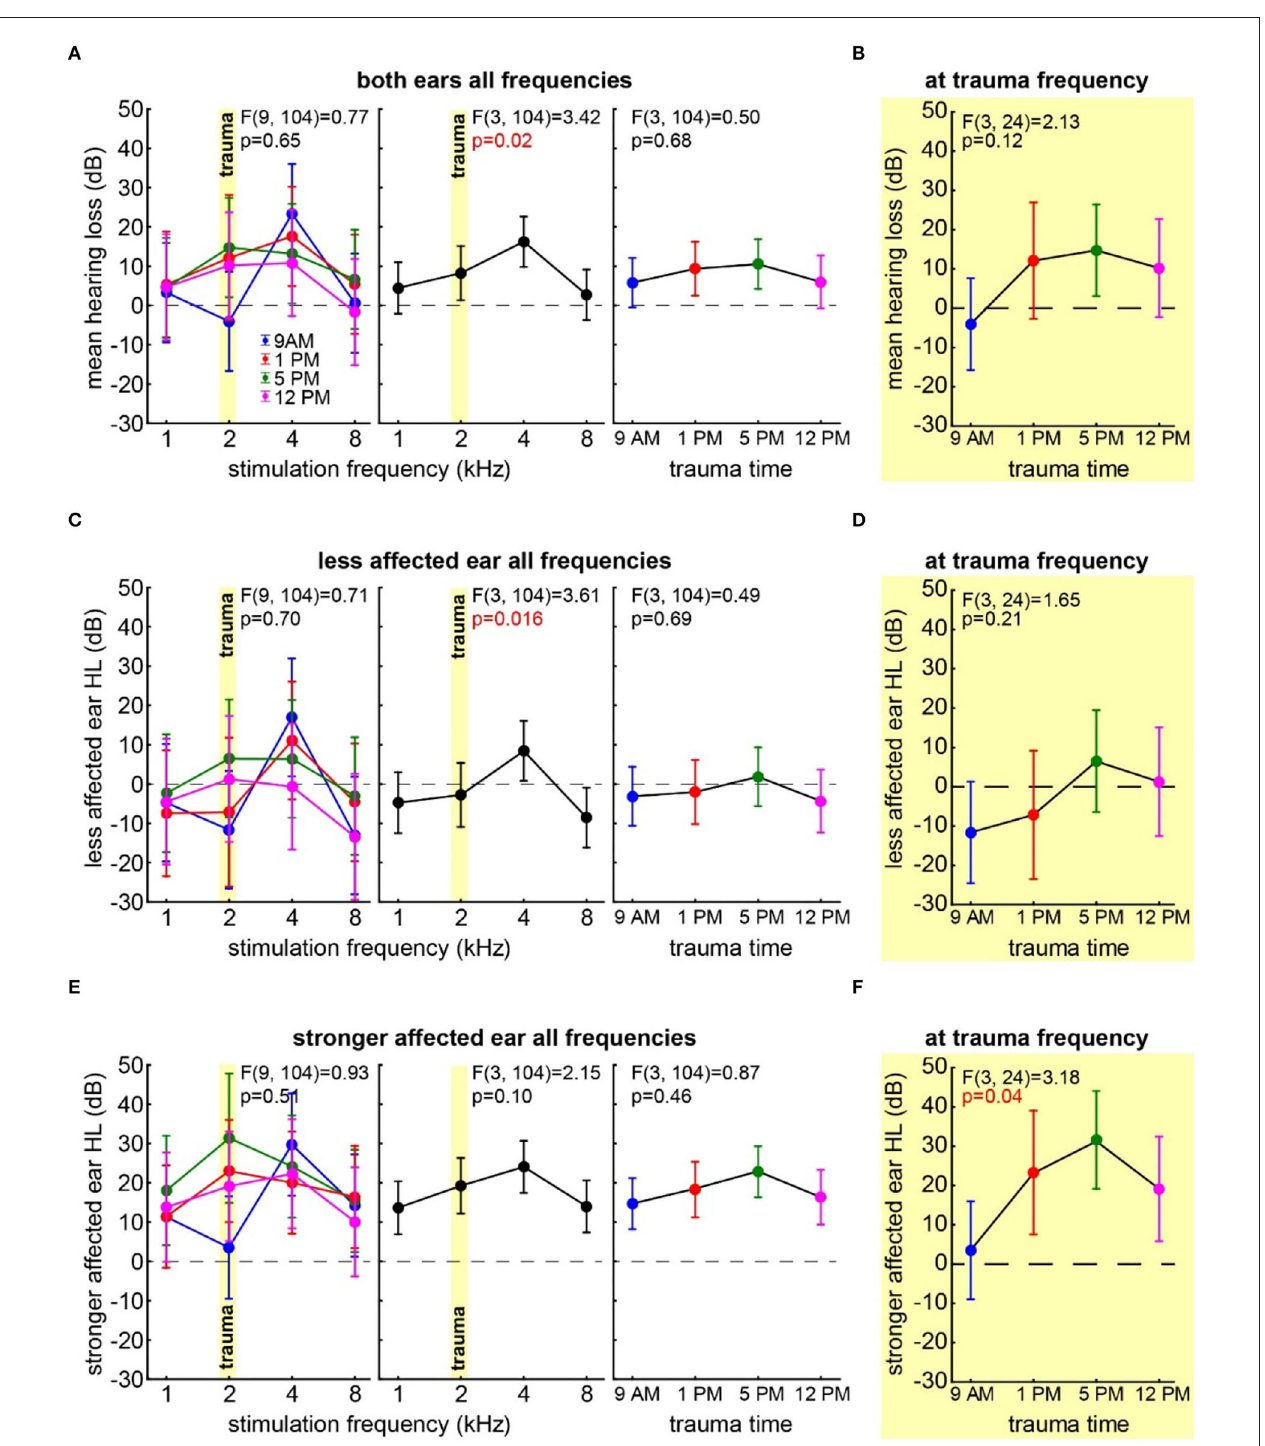
FIGURE 2 | Hearing loss one week after trauma at different times of the day. (A) Mean HL across both ears analyzed by a two-factorial ANOVA with factors time of day (right panel) and frequency (center panel), the interaction of both factors is depicted in the left panel, time of day is color-coded, the trauma frequency is marked by a yellow bar, and whiskers give the 95% confidence intervals, significant p -values of the F-statistics are red. (B) One-factorial ANOVA of the mean HL of both ears at the trauma frequency over the time of day . (C) Two-factorial ANOVA of the HL of the less affected ear with factors time of day and frequency . (D) One-factorial ANOVA of the HL of the less affected ear at the trauma frequency over the time of day . (E) Two-factorial ANOVA of the HL of the stronger affected ear with factors time of day and frequency . (F) One-factorial ANOVA of the HL of the stronger affected ear at the trauma frequency over the time of day .